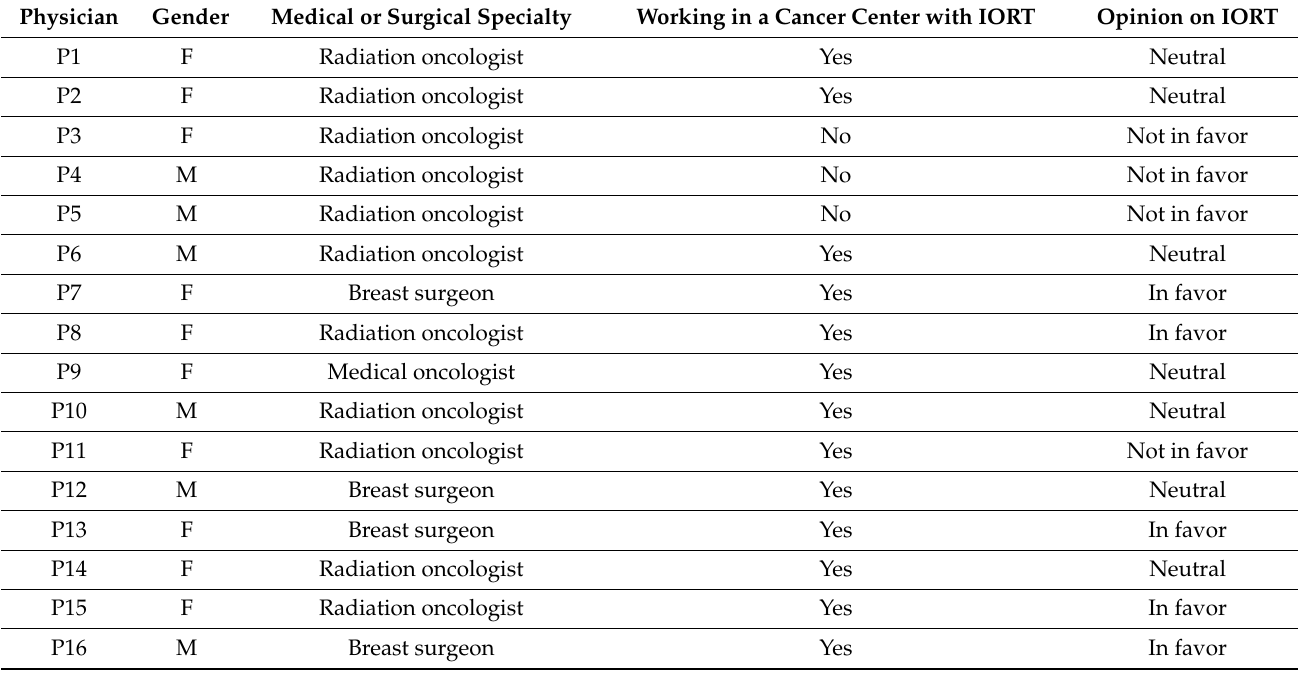
Table 1. Characteristics and opinions of the interviewed